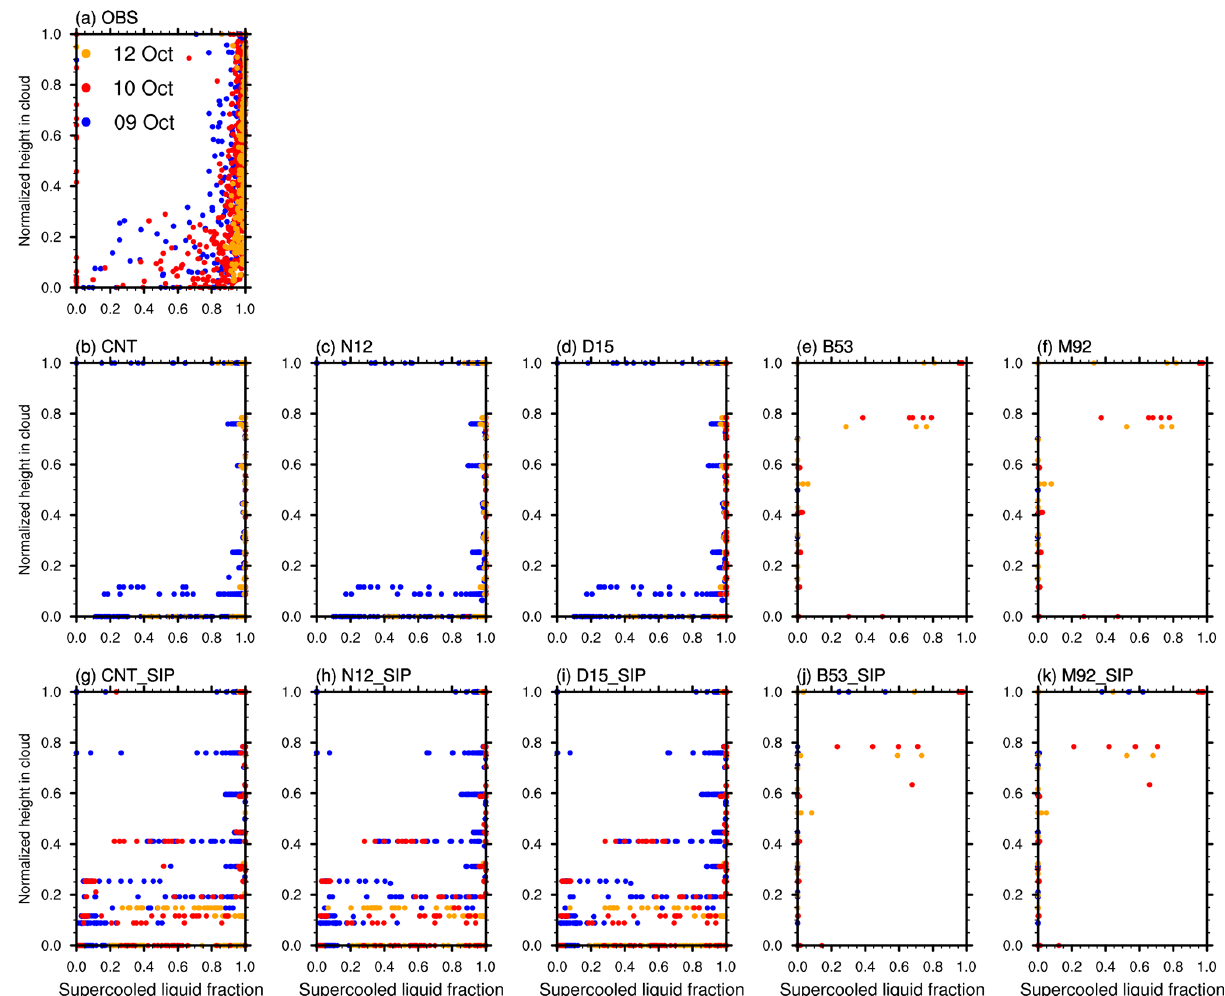
Figure 6. Supercooled liquid fraction (defined as LWC / (LWC + IWC)) as a function of normalized cloud height (i.e., 0 for cloud base and 1 for cloud top) from observations and model experiments. The cloud base and cloud top used for (a) are provided from in situ observations (McFarquhar et al., 2007), and those used for the model analyses (b–k) are derived by searching the model layers from the model top to the bottom with modeled total cloud water LWC + IWC > 10 − 6 kgkg − 1